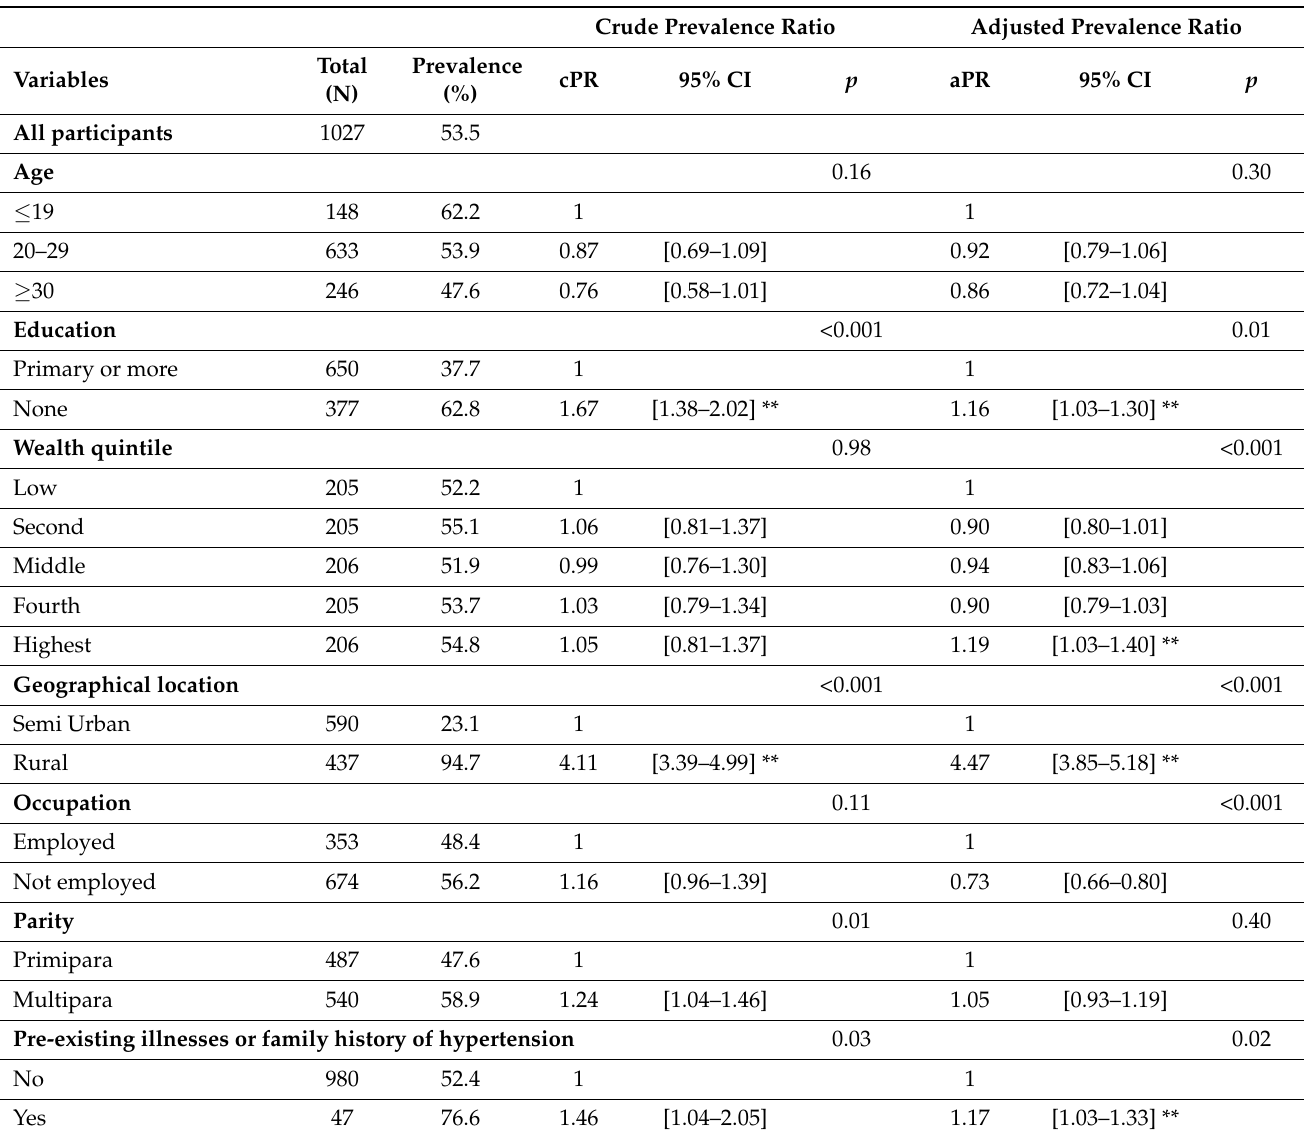
Table 5. Insufficient consumption of fruit and vegetables among pregnant women and associated factors in rural and semi-urban Burkina Faso, 2019; (Crude, adjusted prevalence ratio, and 95% CI). Crude Prevalence